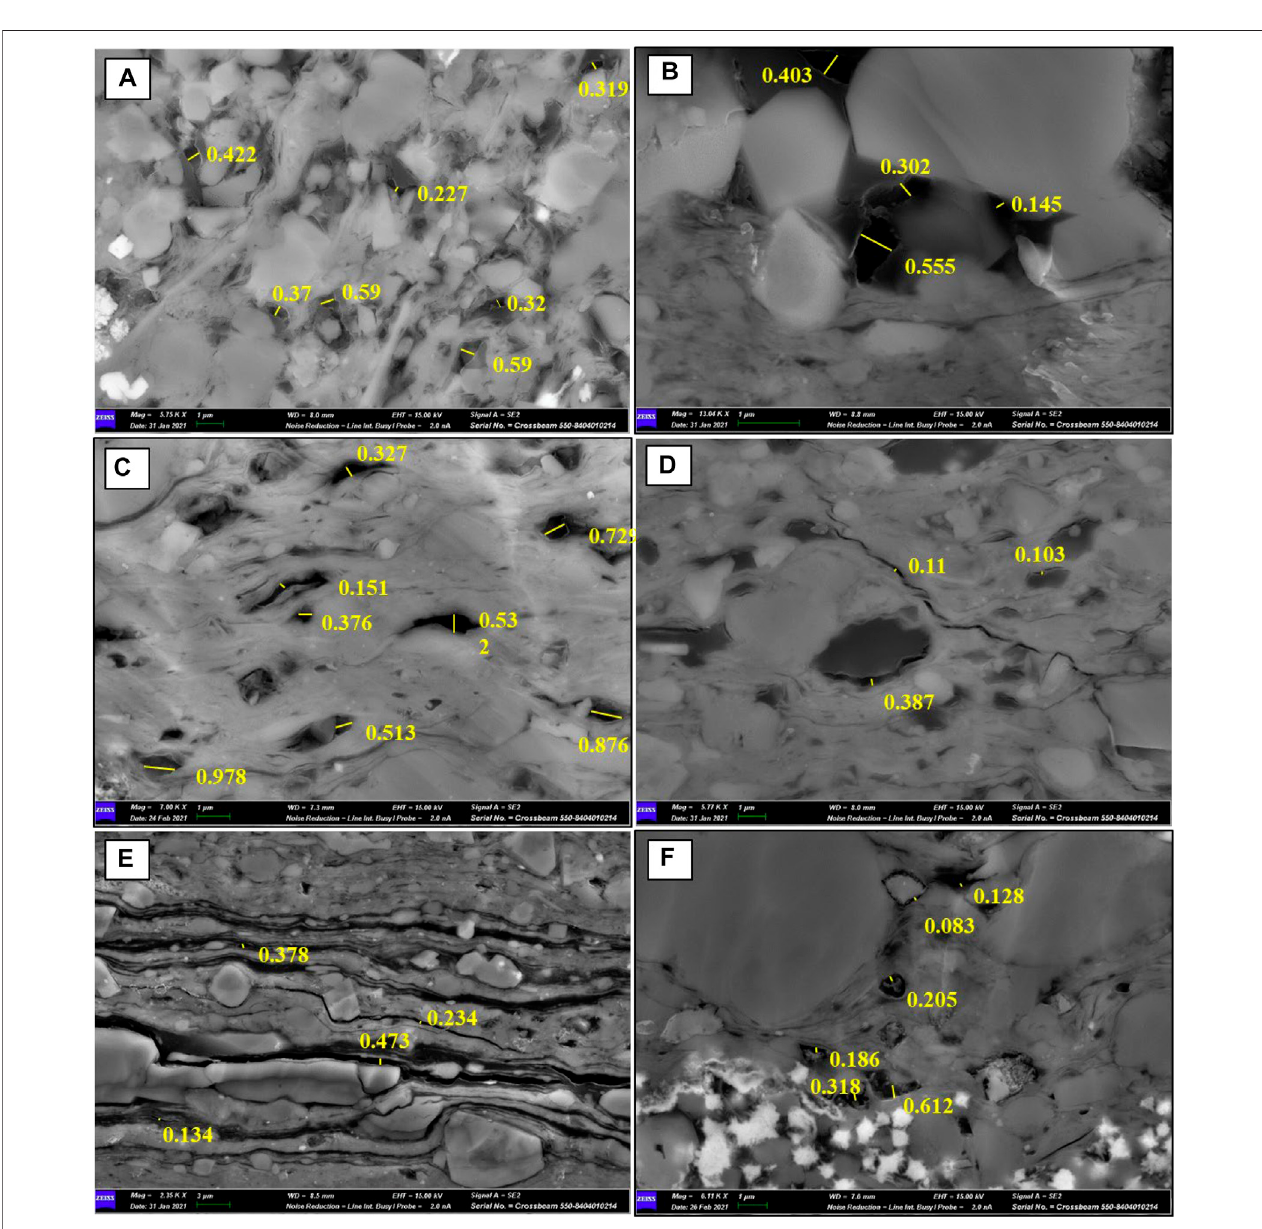
FIGURE8| Poremorphologyanddistributionoforganicmatterintheshales: (A) Sample1,3783.69m; (B) Sample2,3784.25m; (C) Sample3,3784.60m; (D) Sample4, 3784.87 m; (E) Sample 5, 3785.12 m; (F) Sample 6, 3785.43 m. (The yellow-color numbers are the measured sizes of organicmatter-hosted pores with a unit ofmicrometers).